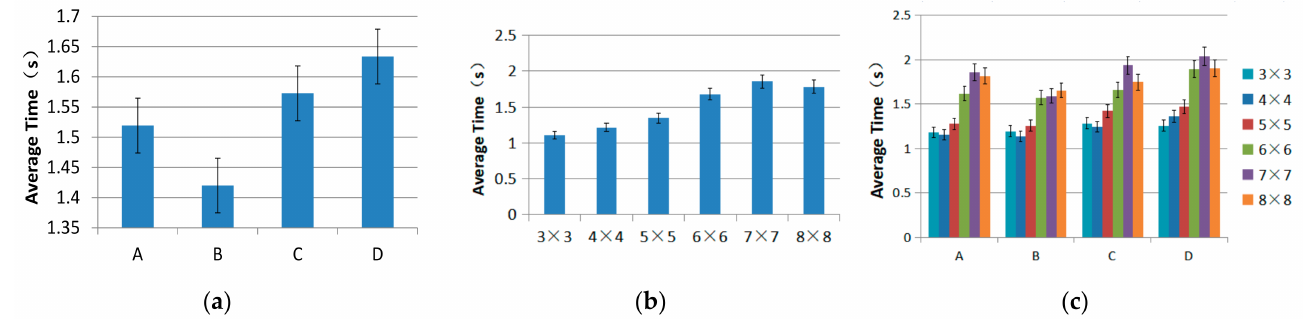
Figure 5. The average time of Experiment 1. The error bars represent a 95% confidence interval: ( a ) average selection time with different regions; ( b ) average selection time with different target size levels; and ( c ) average selection time for different target size levels and different regions (A, B, C, and